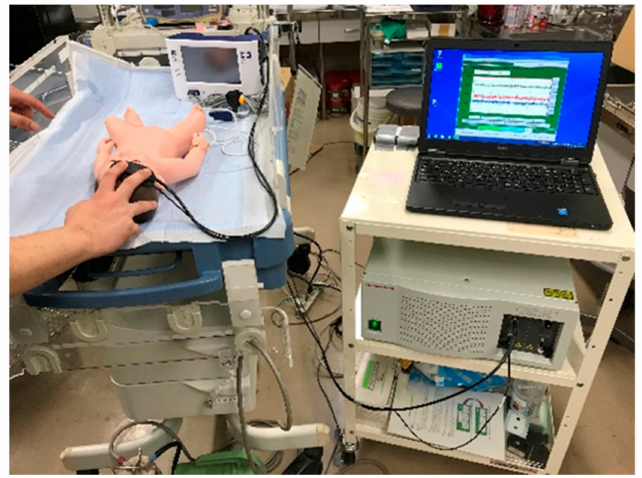
Figure 1. Photograph showing the actual near-infrared time-resolved spectroscopy (TRS)